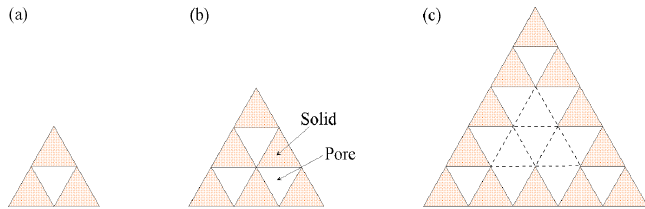
Figure 2. Three kinds of Sierpinski gasket [30]: (a) L a = 2; (b) L a = 3; and (c) L a =